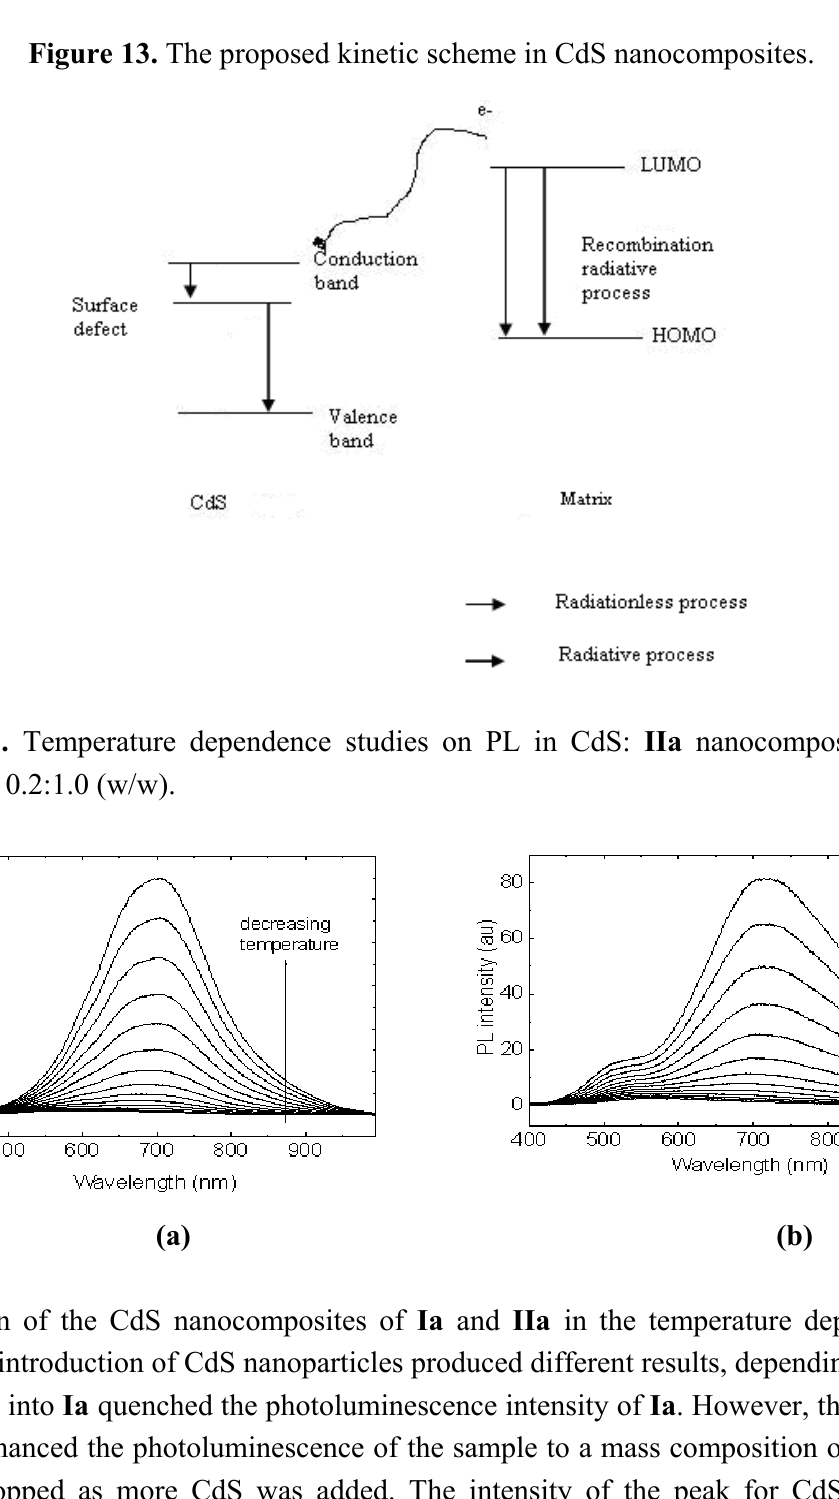
Figure 13. The proposed kinetic scheme in CdS nanocomposites.